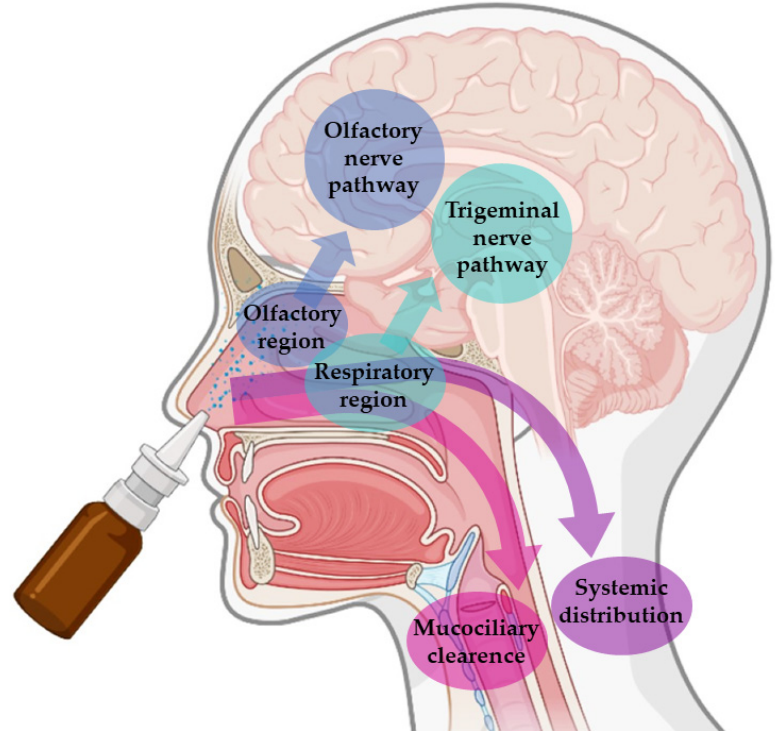
Figure 1. Pathways of brain drug transport after intranasal administration: direct transport (neuronal transport—olfactory nerve and trigeminal nerves) and indirect transport (systemic distribution).